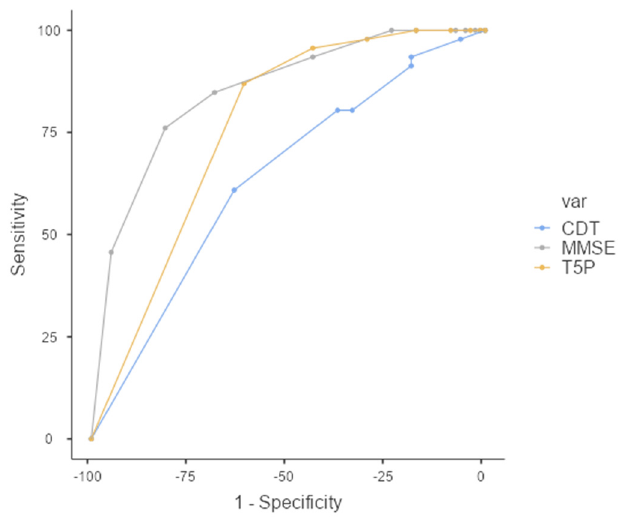
Figure 4. ROC Curve—T5P total score ≤ 9 discriminates between the MCI and FMD groups. MMSE: Mini-Mental State Examination, CDT: clock drawing test, T5P = Test delle 5 Parole.